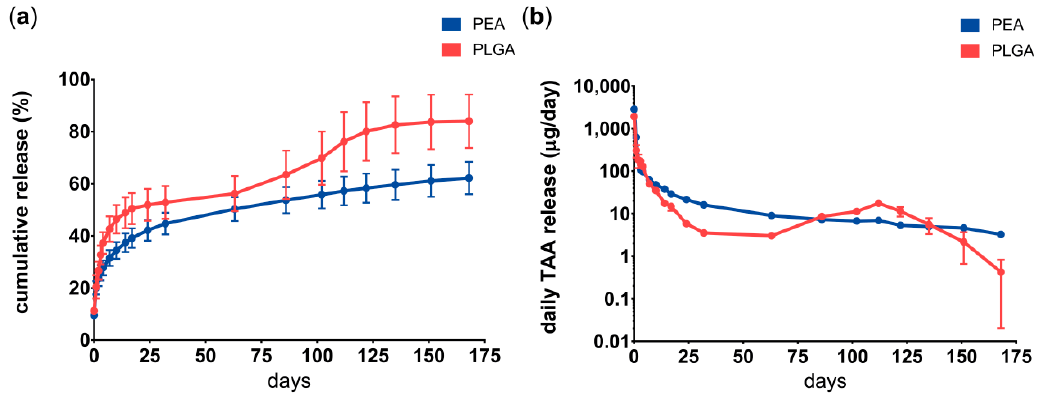
Figure 4. Triamcinolone acetonide from autoregulatory polyesteramide (PEA) or PLGA microspheres is released in vitro over 24 weeks. ( a ) Cumulative triamcinolone acetonide (TAA) release from PLGA (red) or PEA (blue) microspheres in PBS medium (left panel) and ( b ) daily TAA release from PLGA (red) or PEA (blue) microspheres (right panel). Data represent mean ± standard deviation (SD) of three microsphere batches per polymer.